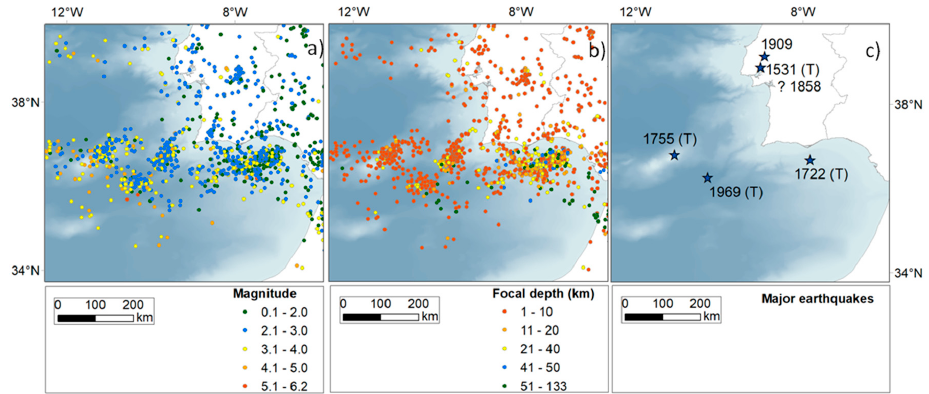
Figure 3. Seismicity in southern Portugal mainland, adapted from [22]: ( a ) Magnitude; ( b ) Focal depth. Data from USGS, from 14 December 2000 to 14 December 2007; ( c ) Major earthquakes. (T) indicates earthquakes that triggered tsunamis. The epicentre of 1858 is unknown.